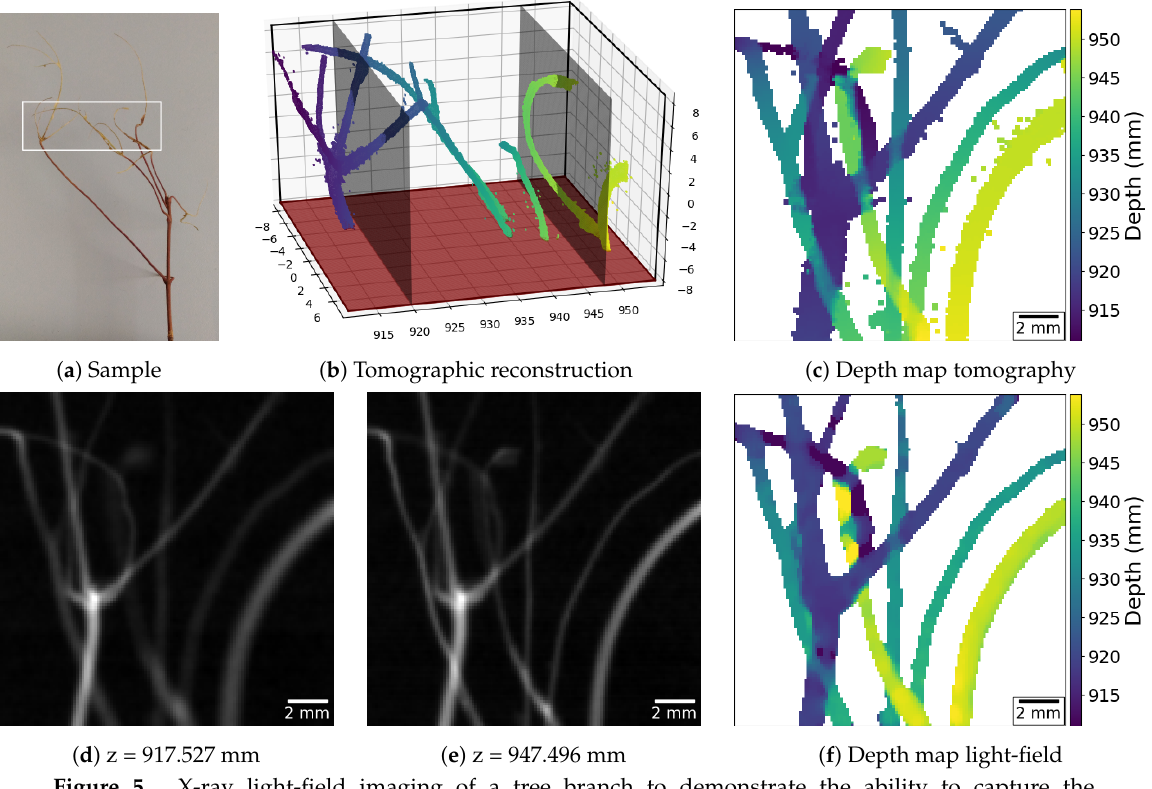
X-ray light-field imaging of a tree branch to demonstrate the ability to capture the three-dimensional (3D) structure of vessel-like objects. The sample is shown in ( a ), where the white box identifies the analyzed region. The traditional CBCT reconstruction is rendered in ( b ). ( d , e ) present the refocus planes shown in ( b ). ( c , f ) present the depth maps extracted from the tomographic reconstruction and the light-field acquisition,